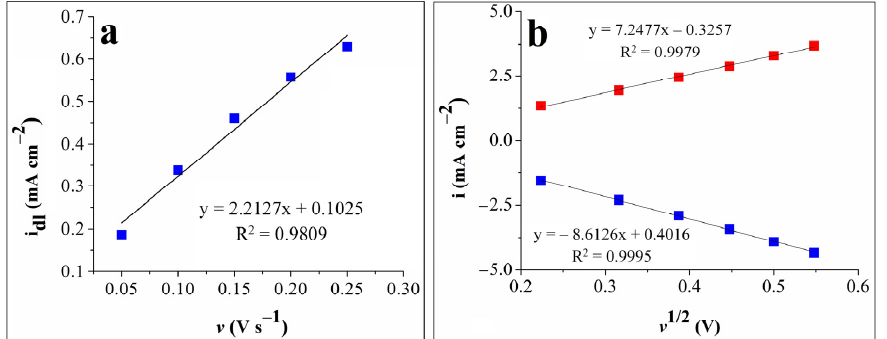
Figure 3. ( a ) The plot of the capacitive current density vs. the scan rate for the G9-modified electrode. ( b ). The graphical representations of the anodic peak current densities vs. the square root of the scan rate (red squares) and of the cathodic peak current densities vs. the square root of the scan rate (blue squares) for the G9-modified electrode.